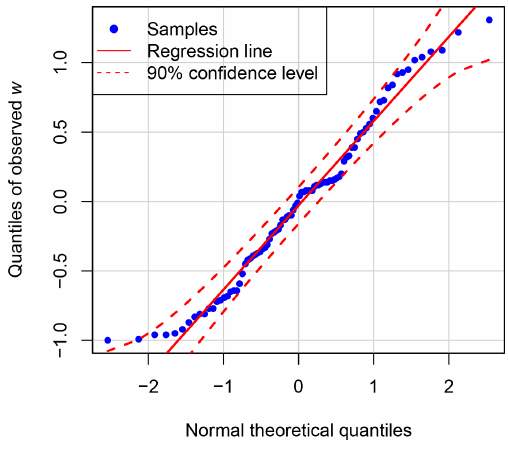
Figure 7. A normal quantile–quantile plot for comparing the ob- served w sampled by aircraft in cloud case CN01 with a standard normal distribution. The linearity of the data points (blue) suggests that the observed w are normally